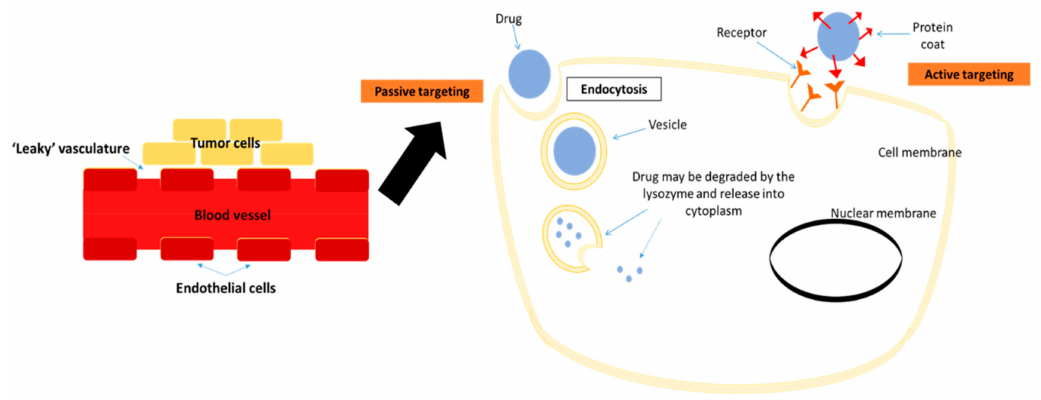
Figure 3. A schematic diagram showing ‘leaky’ vasculature of blood vessels at the tumor site, thus encouraging passive targeting of drug delivery. Active targeting employs the protein coating on the drug’s surface to attract receptor binding upon drug delivery into the target